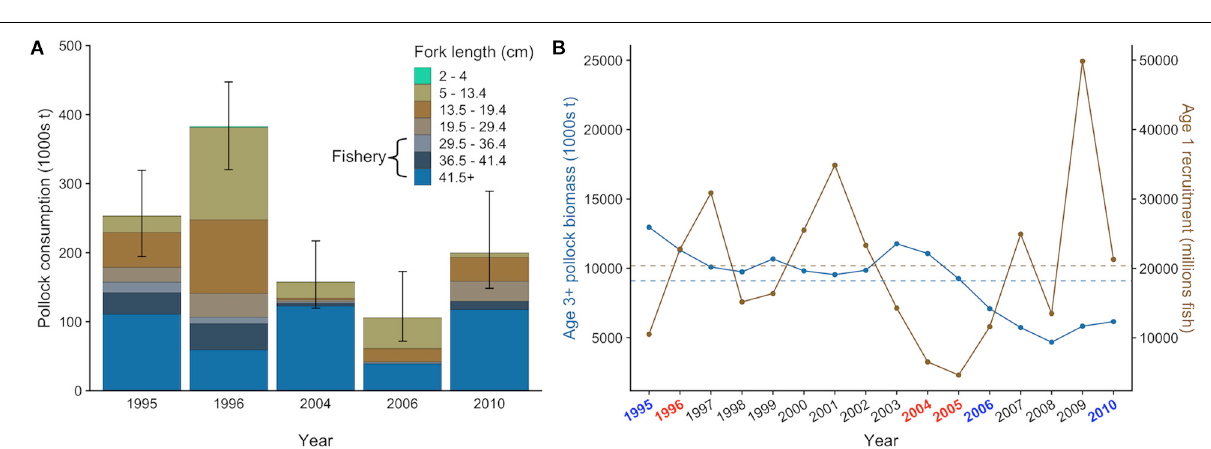
FIGURE 4 | Size-specific walleye pollock consumption by northern fur seals from the Pribilof Islands with 95% confidence intervals that incorporate uncertainty in diet and population size estimates (A) and actual (points) and average (dashed lines) biomass of age-3+ pollock and age-1 recruitment in the eastern Bering Sea from 1995 to 2010 estimated from the 2019 stock assessment (B) . In (A) , the approximate size range of pollock targeted by the fishery is highlighted. In (B) , target years are colored based on their general classification as “warm” (red) or “cold” (blue) based on bottom water temperatures measured on the eastern Bering Sea shelf in June and